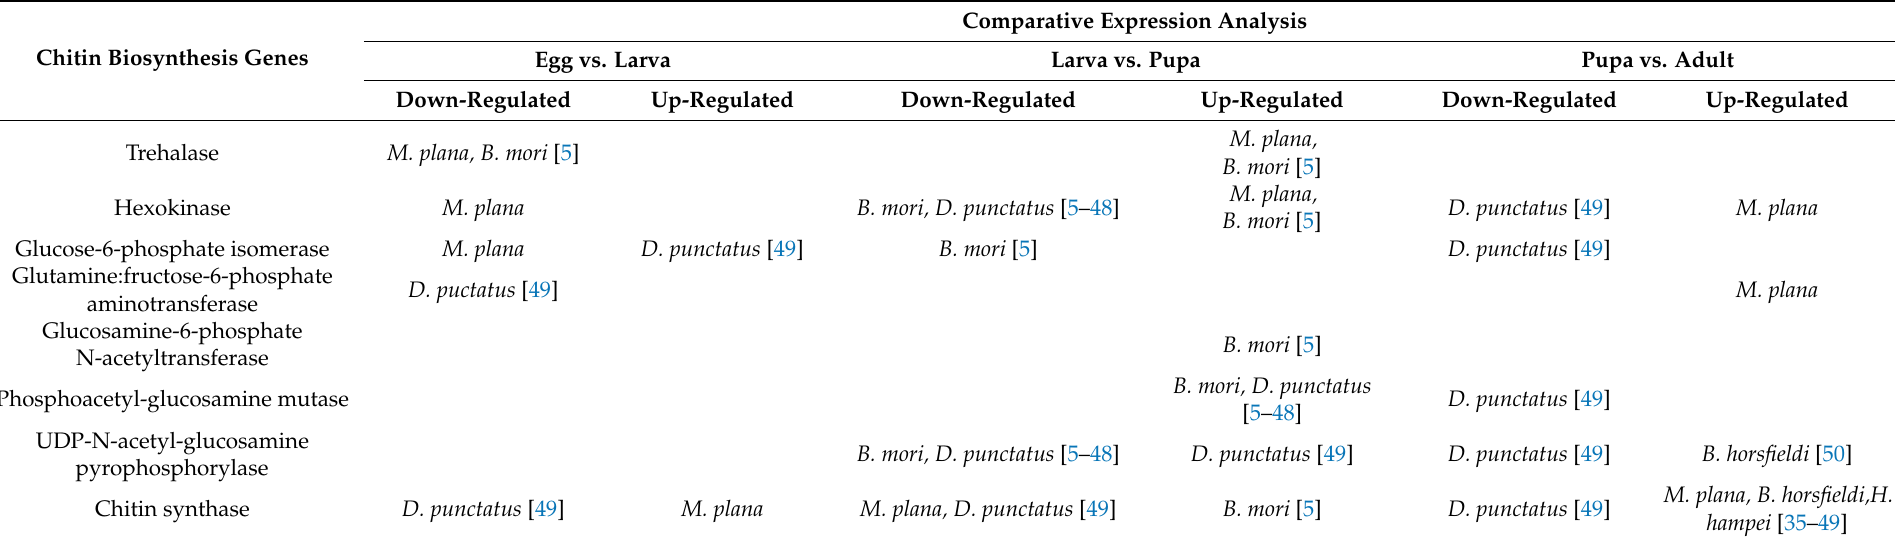
Table 2. Comparative differential expression analysis of chitin biosynthesis genes of different insects species as compared to M. plana at three comparisons: egg against larva, larva against pupa and pupa against